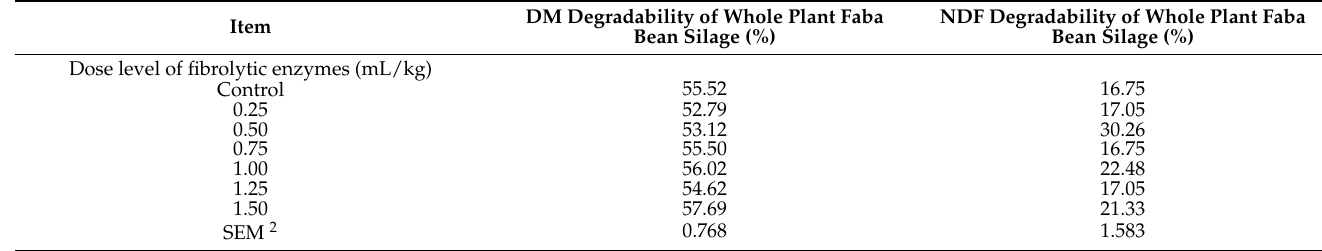
Table 3. Effect of different dosage of fibrolytic enzymes 1 derived from Trichoderma reesei on in